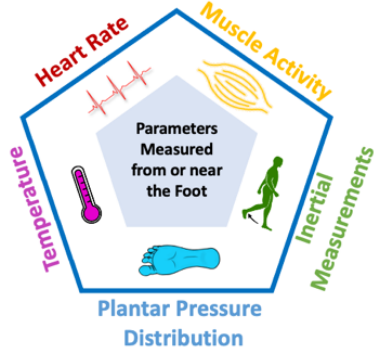
Figure 5. Parameters which have been measured at or near the foot.